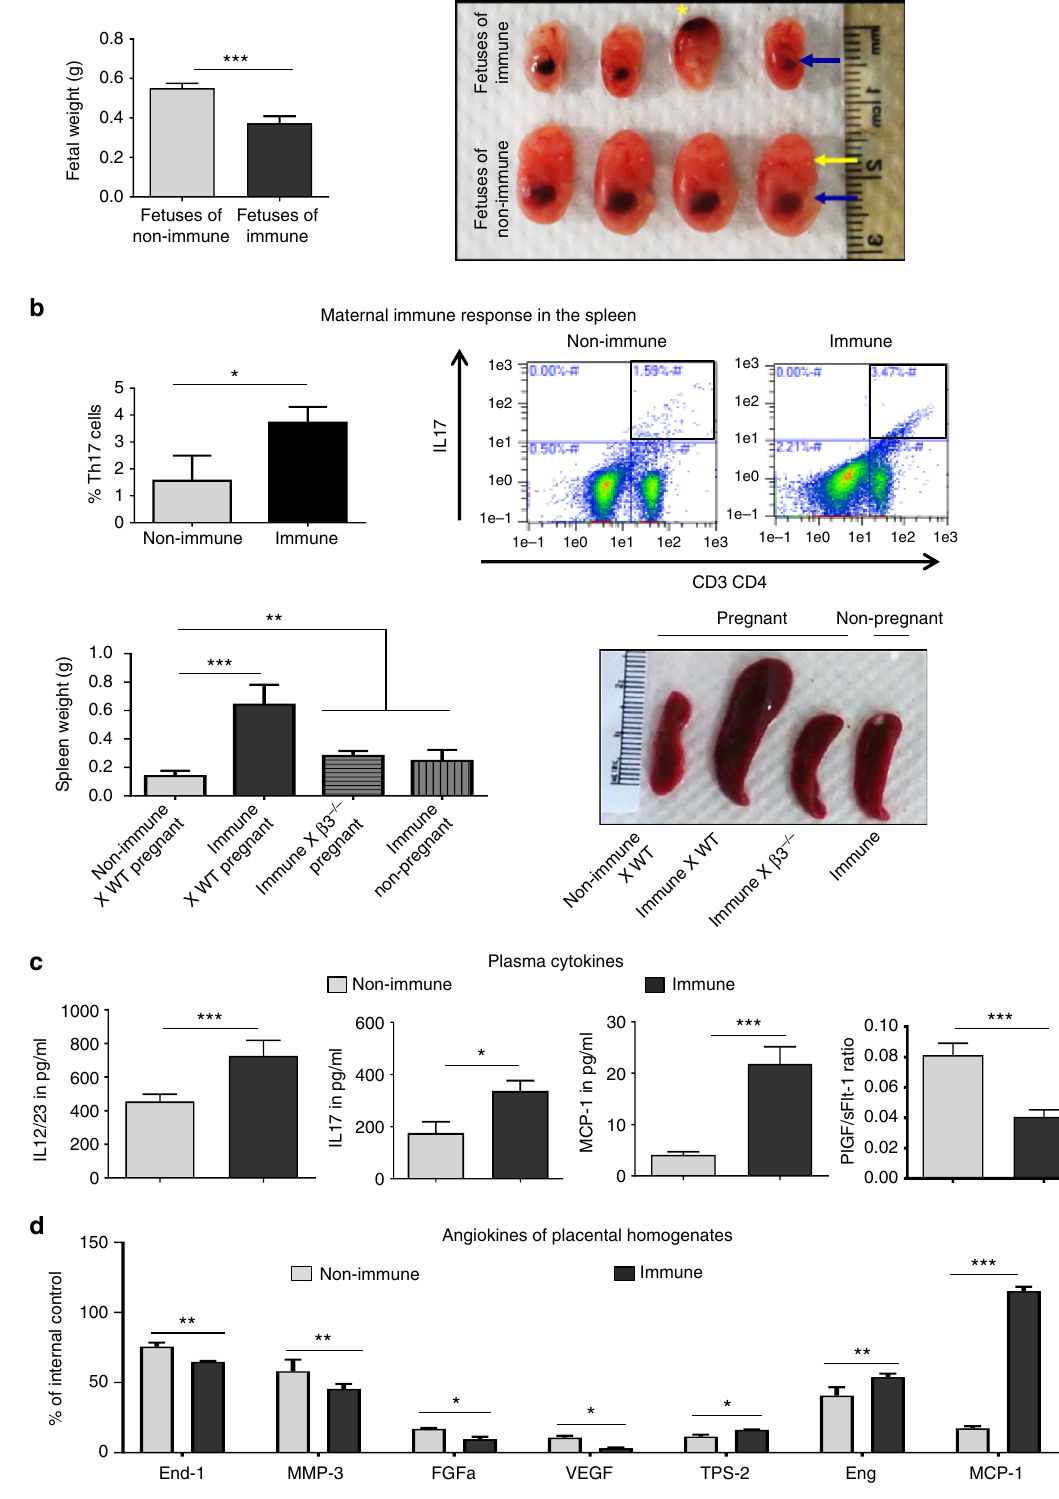
Fig. 1 Maternal immune responses to fetal platelet β 3 integrin cause IUGR and fetal death in FNAIT at E14.5. a Fetuses from immune mice had signi fi cantly impaired growth as revealed in the top panel by body weight and gross examination (liver = blue arrow , eye = yellow arrow , ICH = yellow star ). b Immune mice developed a Th17 pro-in fl ammatory response ( top panels ) and splenomegaly ( bottom panels ) during pregnancy compared to non-immune pregnant mice. c Circulating Th17-polarized cytokines were also elevated in immune pregnant mice. Both plasma ( c ) and placental ( d ) angiogenic cytokines were signi fi cantly decreased in immune mice compared to non-immune pregnant mice. Data were collected from more than 30 pregnancies per group. End-1 endothelin-1, Eng endoglin, FGFa fi broblast growth factor acidic, MCP-1 monocyte chemoattractant protein-1, MMP-3 matrix metalloproteinase, TSP-2 thrombospondin-2, VEFG vascular endothelial growth factor, Unpaired Student ’ s t -test. Mean ± SEM. * p < 0.05, ** p < 0.01 and *** p <